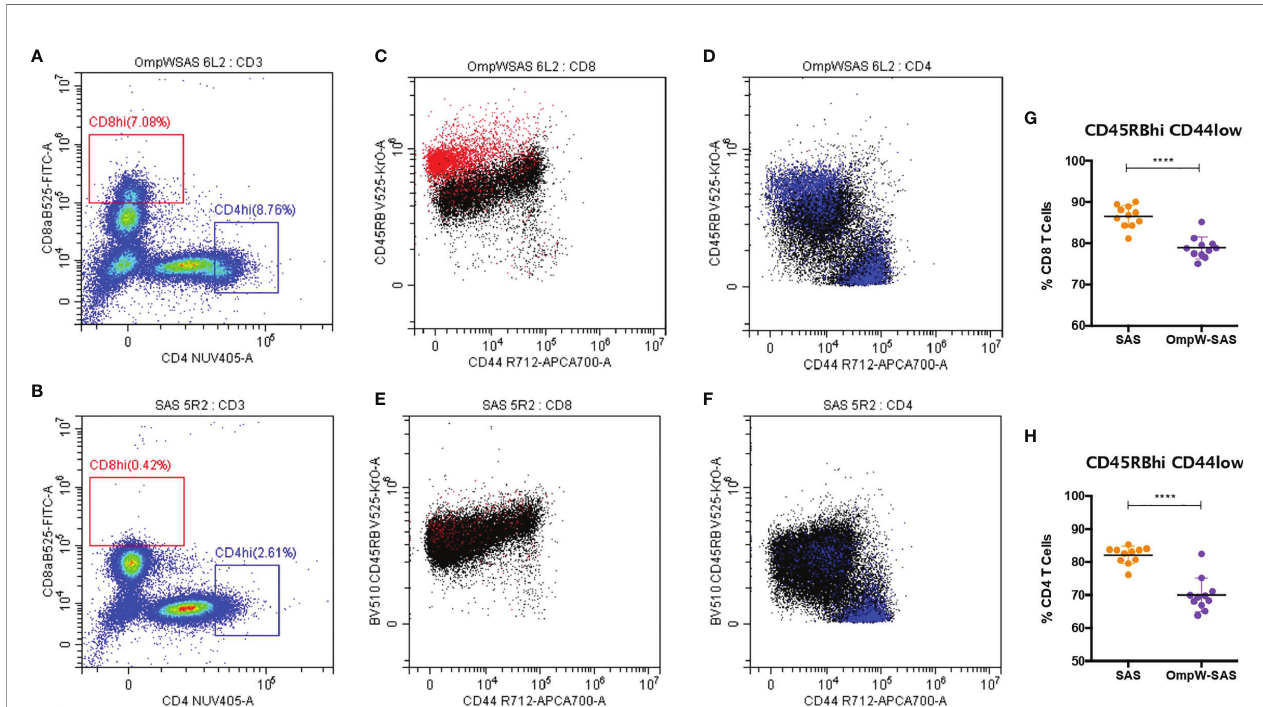
FIGURE 2 | BpOmpW-stimulated CD8 hi and CD4 hi populations that are CD45RB hi CD44 lo . (A, B) Splenocytes of CD8 hi (in red ) and CD4 hi (in blue ) populations from both SAS-adjuvanted BpOmpW-immunized mice re-exposed to BpOmpW ( n = 11) (A) and from adjuvant-only mice exposed to BpOmpW ( n = 11) (B) . (C, D) CD4 (C) and CD8 (D) T-cell co-expressions of CD45RB and CD44 in BpOmpW-re-exposed splenocytes from SAS-adjuvanted BpOmpW-immunized mice. (E, F) CD4 (E) and CD8 (F) T-cell co-expressions of CD45RB and CD44 in BpOmpW-exposed splenocytes from SAS-adjuvanted saline-immunized mice. (G, H) Naive CD4 and CD8 T cells (CD45RB hi CD44 lo ) including CD45RB veryhi populations as naive T cells. BpOmpW , homologue OmpW in Burkholderia pseudomallei ; SAS , Sigma Adjuvant System. The levels of signi fi cance are represented as follows: **** p <